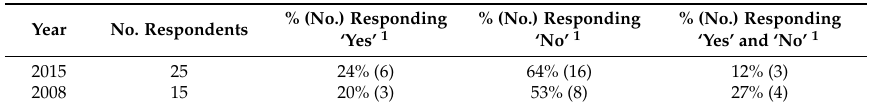
Table 3. Responses of university veterinary teaching staff from Australia and New Zealand in 2008 and 2015 to the question ‘In your teaching of desexing to students of both female and male cats and dogs, are you advocating the use of early age desexing (EAD)?’.